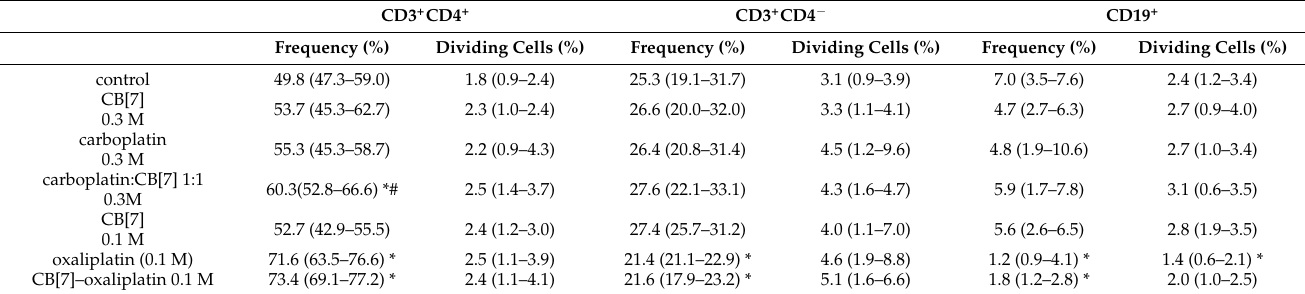
Table 2. The relative number and level of anti-CD3 stimulated proliferation of various subpopulations of